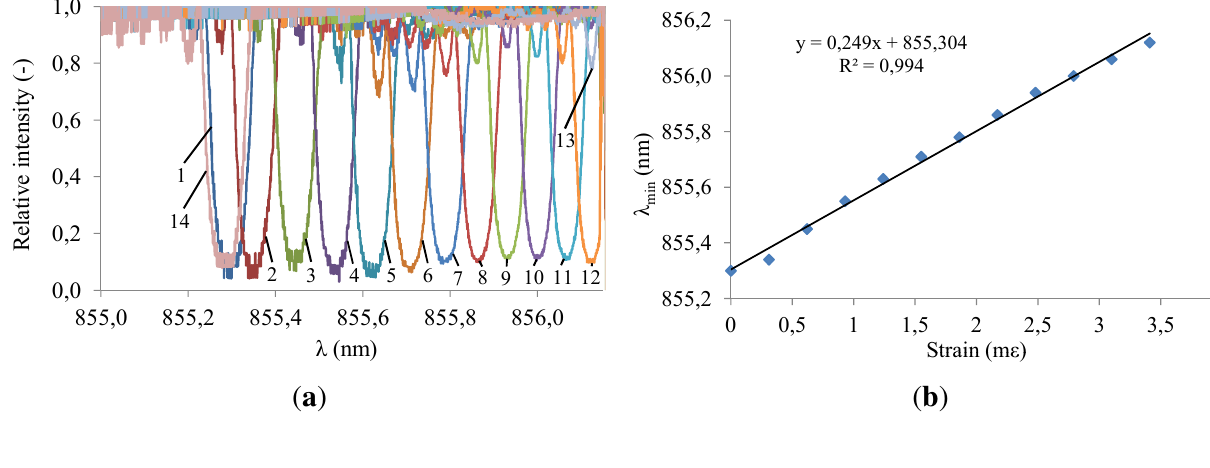
Figure 14. Strain characterization of the fully embedded system. ( a ) 1: 0 m (cid:15) , 2: 0.31 m (cid:15) , 3: 0.62 m (cid:15) , 4: 0.93 m (cid:15) , 5: 1.24 m (cid:15) , 6: 1.55 m (cid:15) , 7: 1.86 m (cid:15) , 8: 2.17 m (cid:15) , 9: 2.48 m (cid:15) , 10: 2.79 m (cid:15) , 11: 3.10 m (cid:15) , 12: 3.41 m (cid:15) , 13: 3.72 m (cid:15) , 14: 0 m (cid:15) . Measured transmission spectra using the integrated VCSEL and photodetector system; ( b ) Wavelength extremum versus axial